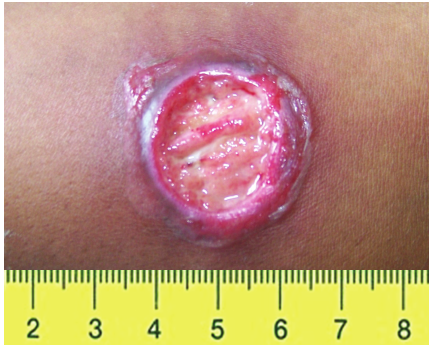
Figure 2: Cutaneous round ulcer with raised borders measuring 26 × 24 mm in the forearm where the Montenegro skin test was